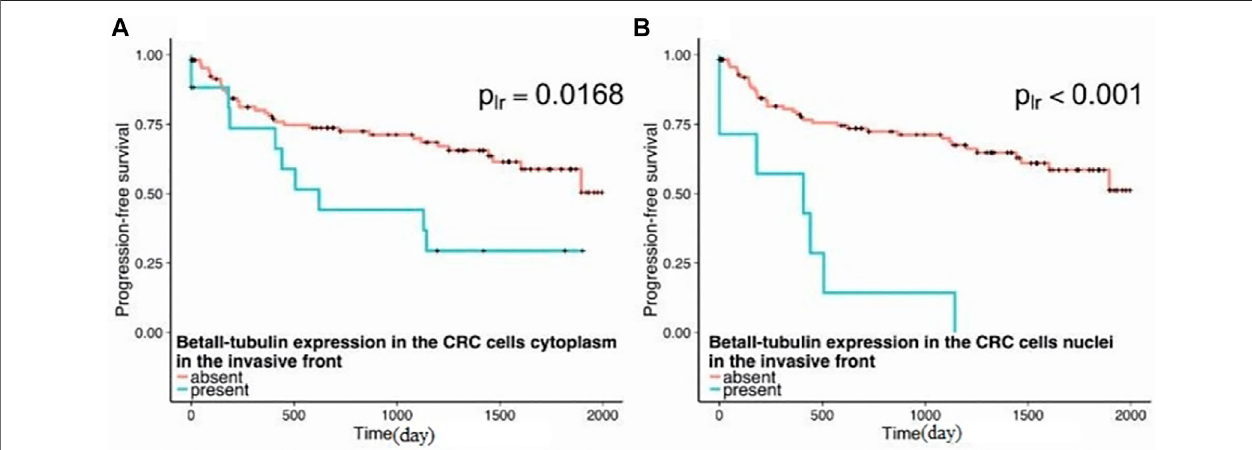
FIGURE 3 | Progression-free survival in patients as a function of the presence of β II-positive staining in the invasive front of colorectal cancer tumors. (A) The progression-freesurvivalisdecreasedinpatientswiththepresenceofcytoplasmic β II-tubulinintheinvasivefront(plr=0.0168). (B) Patientswiththepresenceofnuclear β II tubulin staining in the invasive front demonstrate worse prognosis in comparison with patients without positive staining in the nuclei (plr < 0.001) (From Ruksha et al., 2019).